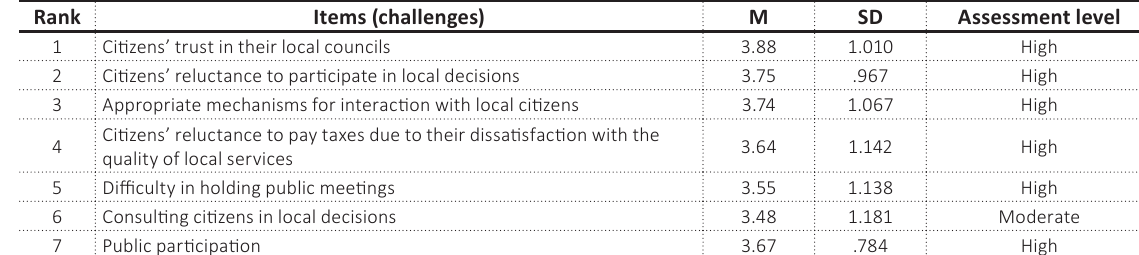
Table 6. Respondents’ assessment of the level of public participation challenges facing local government